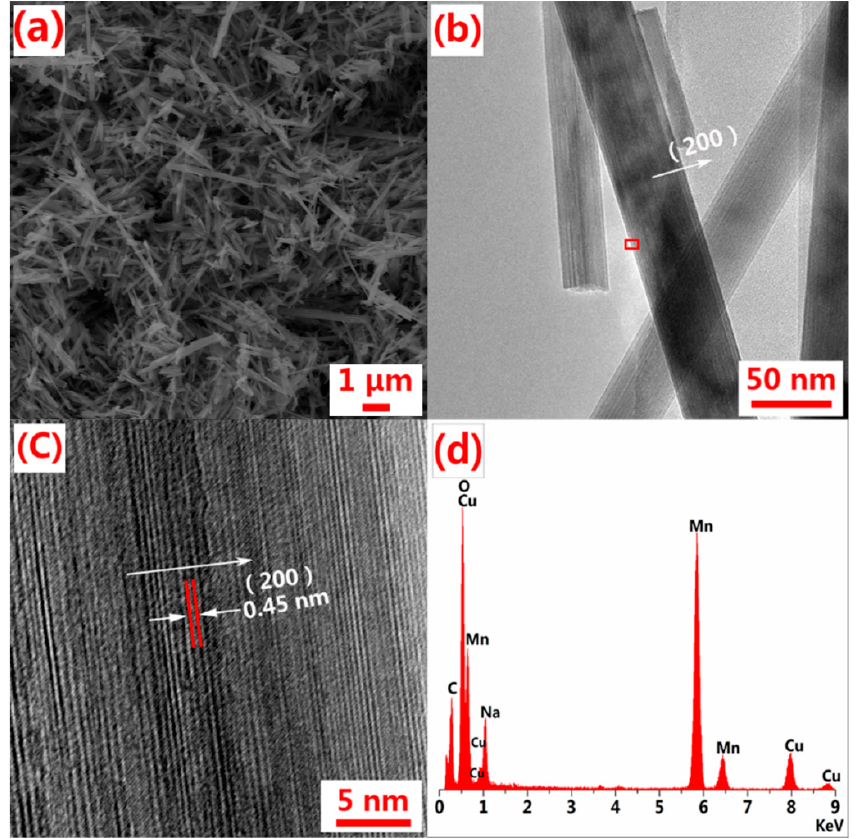
Figure 3. ( a ) SEM and ( b ) TEM image of Na 4 Mn 9 O 18 ; ( c ) HR-TEM image and ( d ) EDS spectrum of Na 4 Mn 9 O 18 .